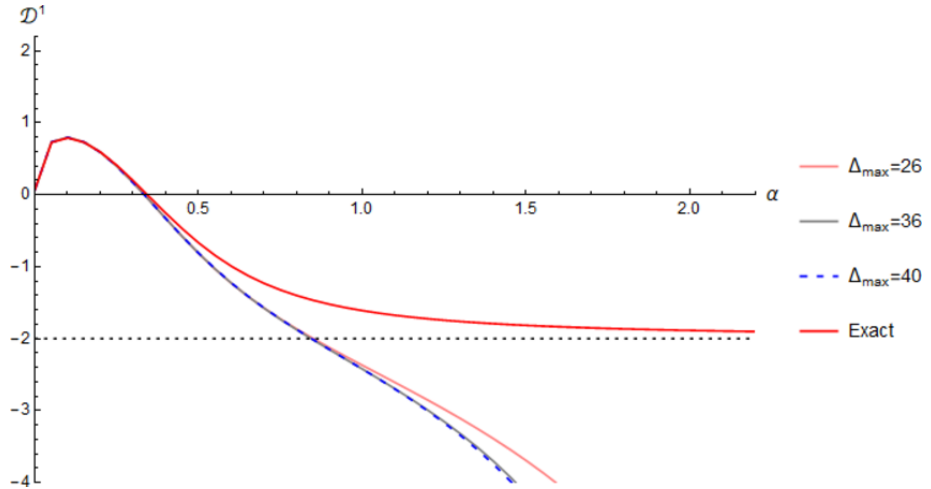
Figure 7. D 1 ( e 1 (cid:0) e 0 ) versus (cid:11) > 0 for the (cid:12)xed spectator. Linear term removed using regression s analysis on the interval 2 < (cid:11) < 4.